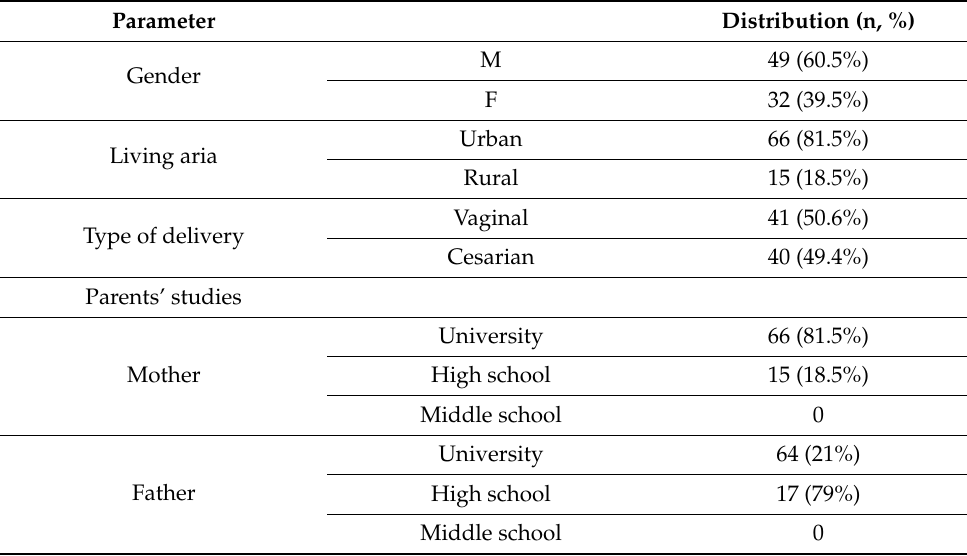
Table 1. Demographic